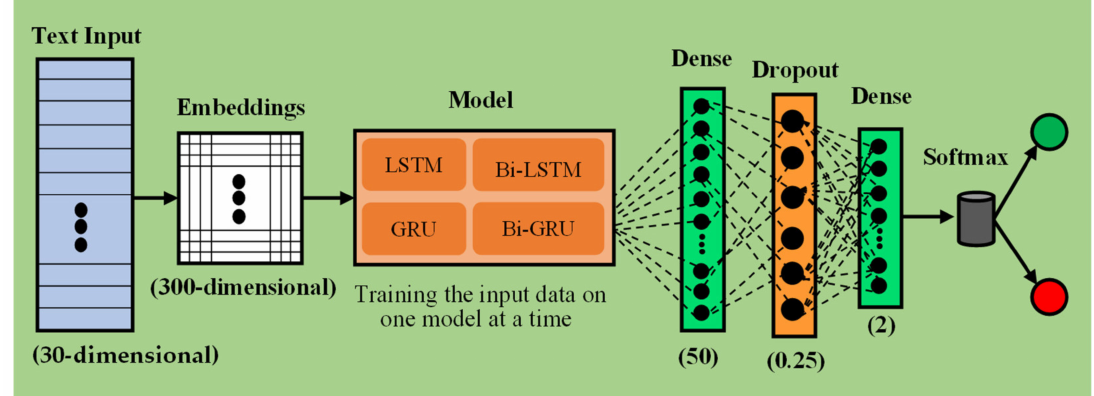
Figure 3. Architectural representation of framework for using LSTM, Bi-LSTM, GRU, and Bi-GRU.